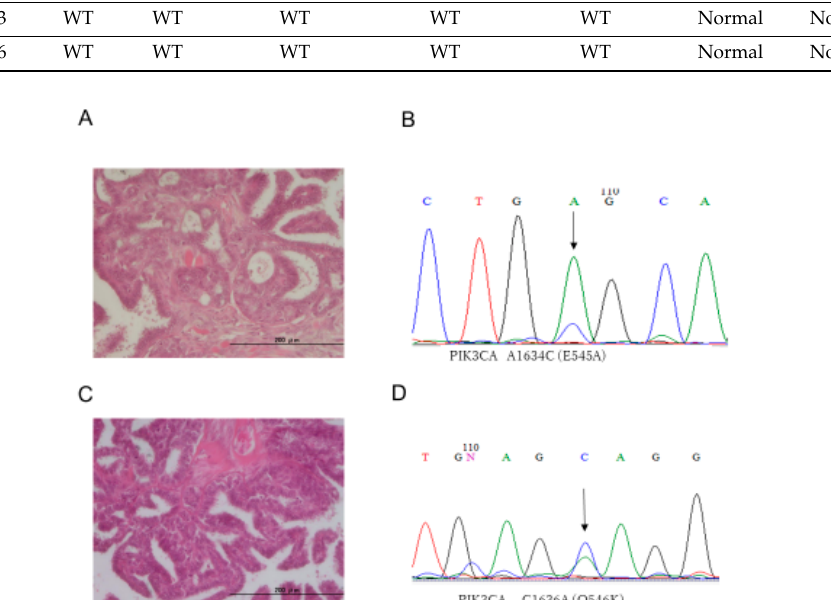
Figure 1. Histopathological images and nucleotide sequences of PIK3CA in representative LGSC and SBT cases. ( A ) Hematoxylin and eosin staining of LGSC sections. ( B ) Nucleotide sequence chromatogram showing a mutation, E545A (1634 A > C), in PIK3CA of an LGSC. ( C ) Hematoxylin and eosin staining of SBT sections. ( D ) Nucleotide sequence chromatogram showing a mutation, Q546K (1636 C > A), in PIK3CA of an SBT. Scale bar = 200 µ m. C; cytosine, T; thymine, G; guanine, A; adenine.